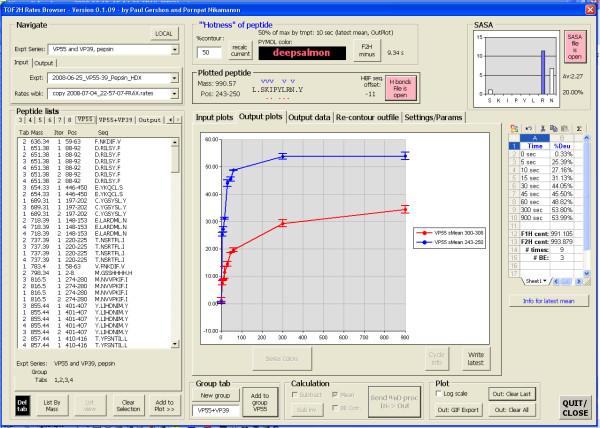
Screen capture of TOF2H-Rates Browser."Navigation" frame: Input "Rates" files data. "Peptide lists" frame, "Group tab" frame: Peptide picking (multi-tabbed by input file or file-group). "Hotness" frame: Suggested color for 3D visualization. "Displayed peptide" frame: Peptide info (red dots = theoretically exchangeable protons based on primary structure considerations only; blue "v" = hydrogen bonded amide protons predicted from crystal structure). Central charts and "Calculation" frame: Rate plot display, manipulation, and send to output chart. "SASA" frame: Main chain amide proton predicted solvent exposure as calculated by SASA [12].